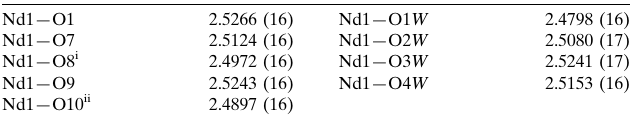
Selected bond lengths (A˚ ).